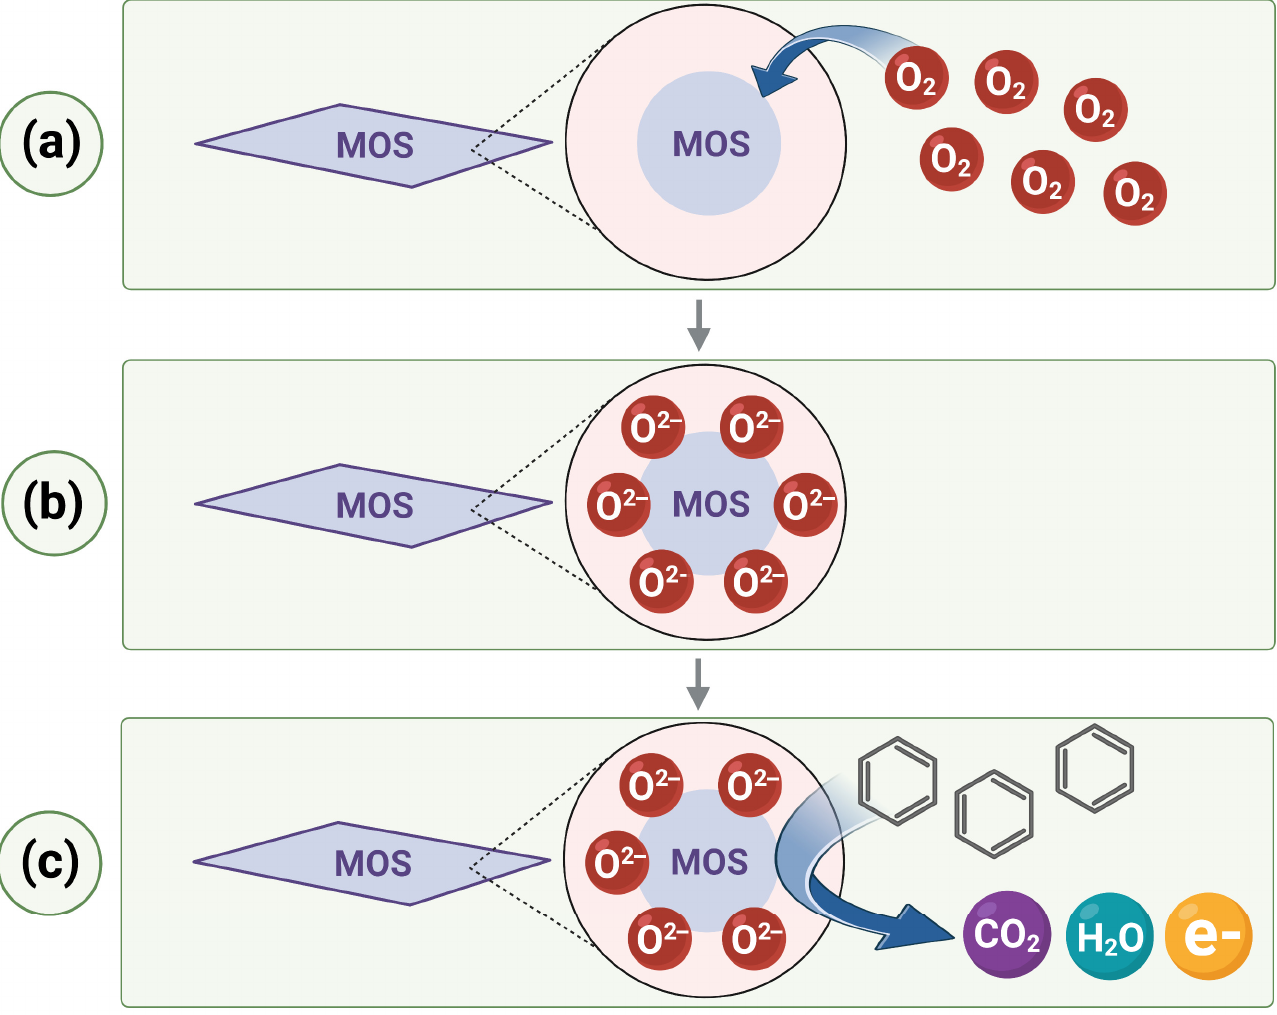
Figure 1. The mechanism of the operation of sensors based on MOS: ( a ) In air environment, oxygen is adsorbed onto the surface of MOS; ( b ) oxygen adsorption creates a surface layer of negatively charged oxygen ions; ( c ) when benzene is present, it is oxidized by negatively charged oxygen ions with the release of electrons, which results in the change in resistance and makes it possible to detect benzene. Image created with biorender.com (accessed on 15 February 2023).